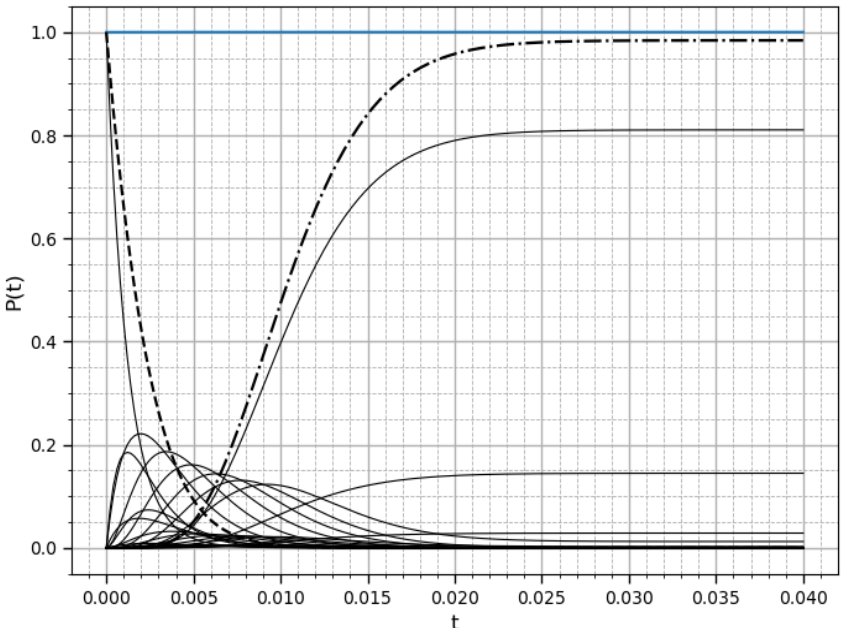
Figure 10. Dependencies of the probabilities on the time. Dashed and dotted line—the probability of losses; dashed line—the servicing device is idle, the buffer is